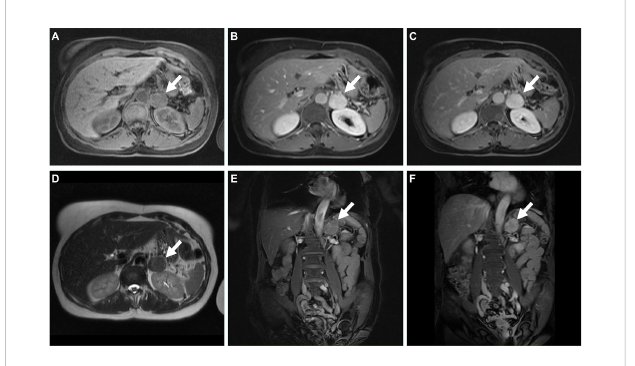
FIGURE 3 (A – F) The graph of immunohistochemical